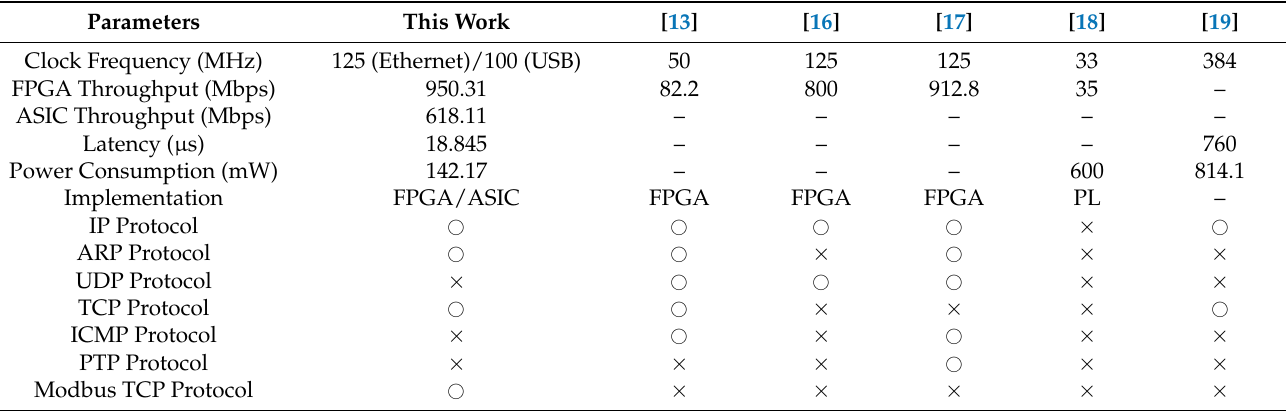
Table 2. Performance comparison with previous